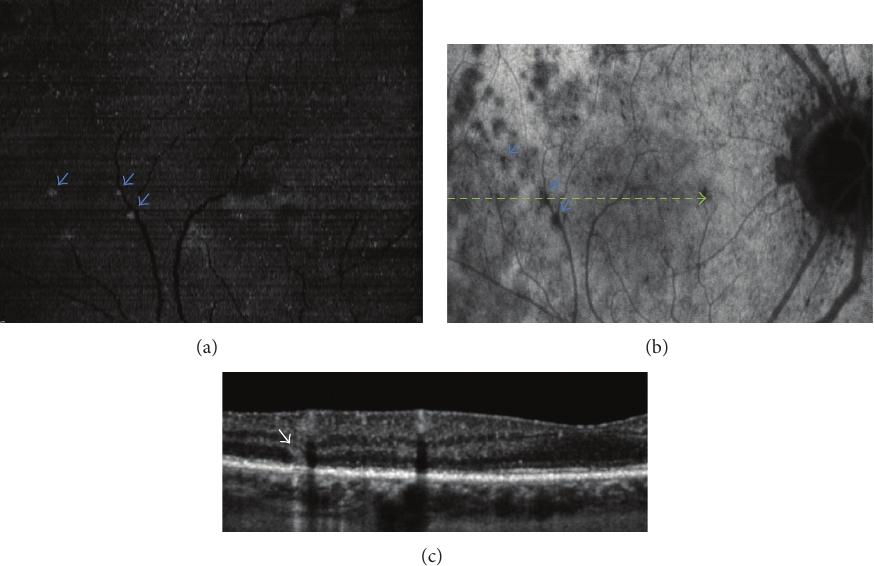
Figure 2: (a) “En-face” EDI SD-OCT showed hyperreflective points in the plane of the outer nuclear layer; (b) ICGA demonstrated dark points (blue arrows) matching the hyperreflective points observed on “en-face” OCT; (c) B-scan at the level of the green line showed spicule- like hyperreflective lesion (white